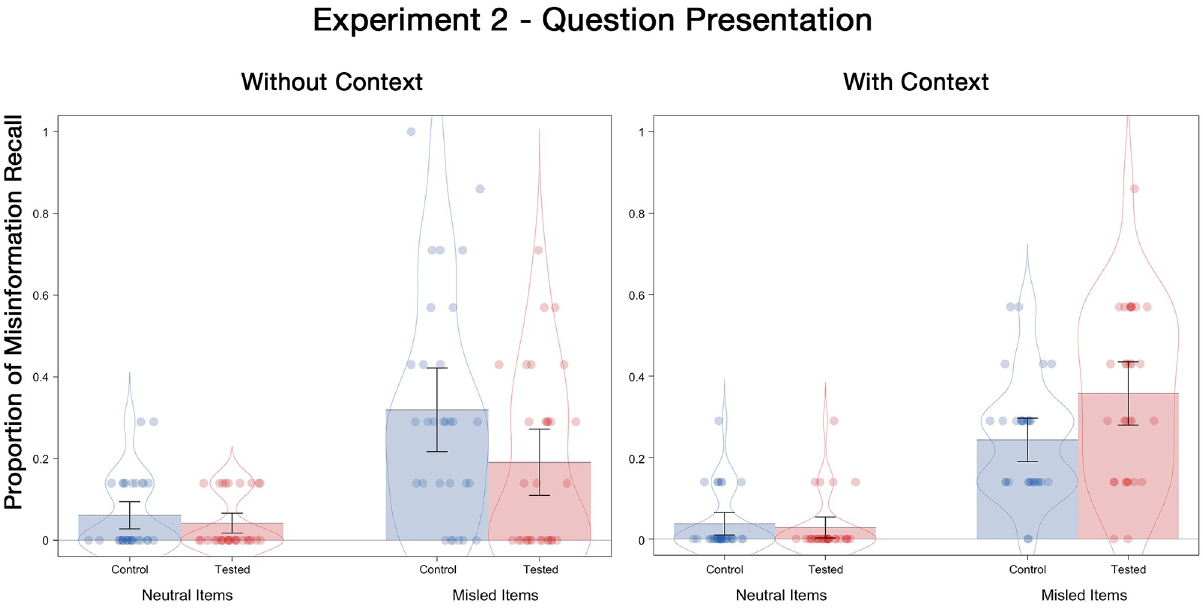
Fig 4. Misinformation recall probabilities for neutral and misled items as a function of the presence or absence of contextual details on the final test of Experiment 2. Error bars indicate descriptive 95% confidence intervals.